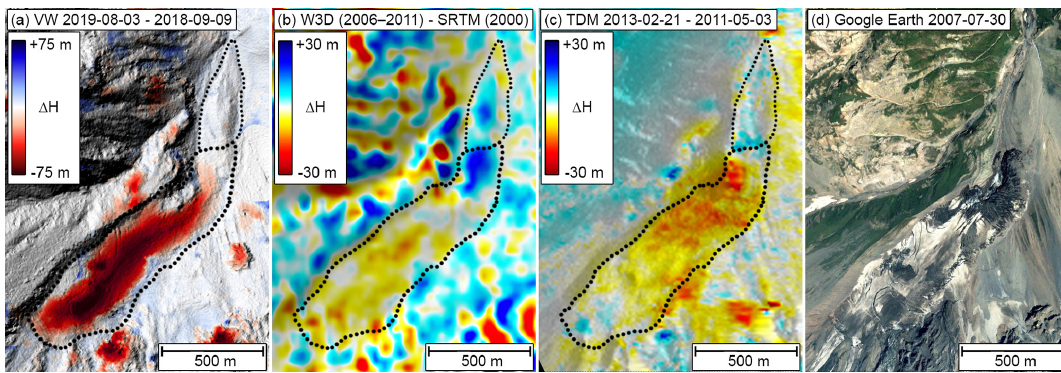
Figure 4. DEM differences of the detachment dp-19. (a) WorldView elevation differences from before and after the event reveal a detached volume of 8 . 6 × 10 6 m 3 . The shown area corresponds to the white frame indicated in Fig. 3a. (b, c) DEM differences indicate a surge-like elevation change pattern after 2000 which continued at least until 2013. (d) In 2007 strong crevassing at the glacier outline resemble surge-like dynamics. (a) 2020, DigitalGlobe, NextView License; (b) 2020, JAXA and USGS; (c) TanDEM-X; (d) © Google, Maxar